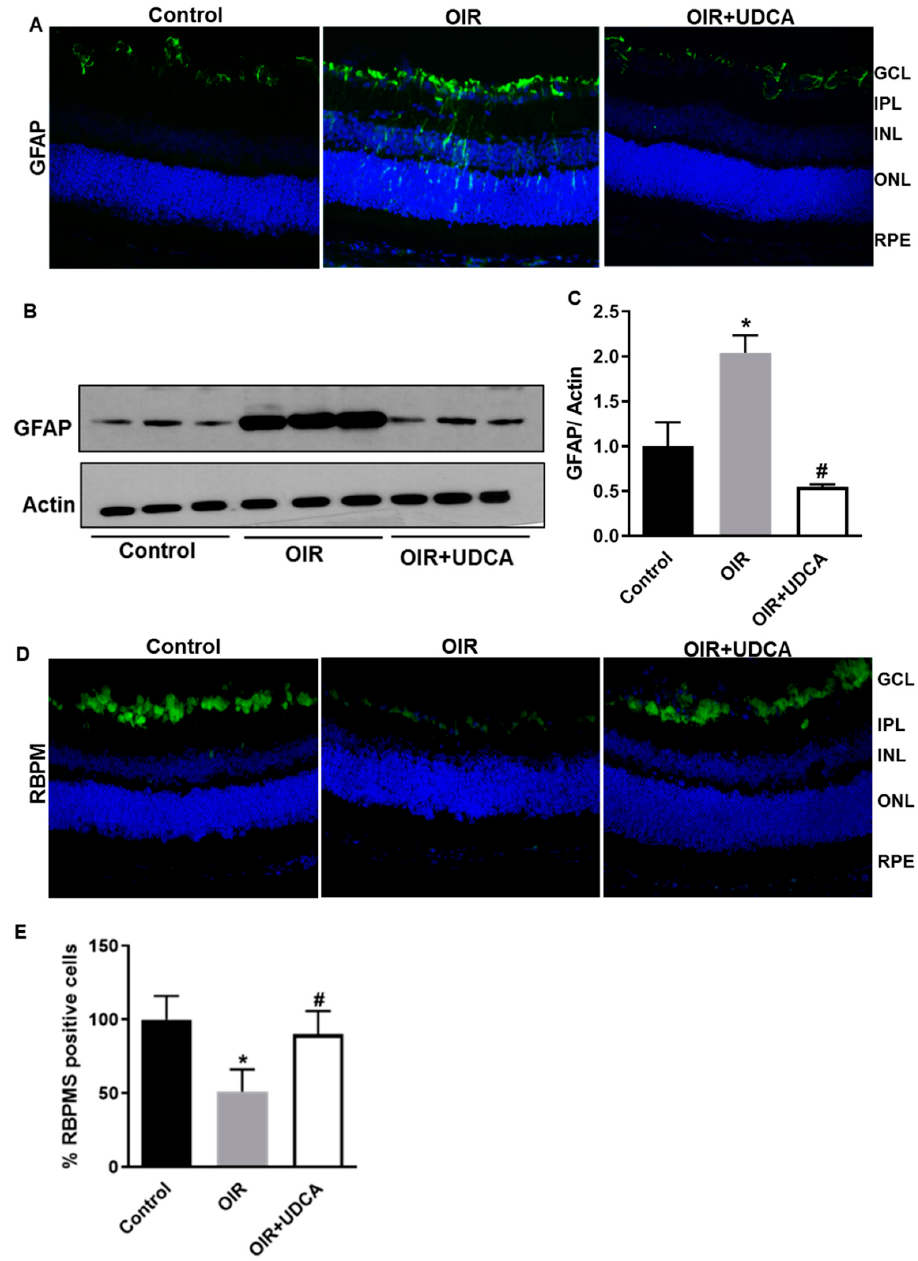
Figure 5. UDCA treatment halts reactive gliosis and preserves neuronal cells in OIR mice. Frozen retinal sections from control mice at P17 (room air), OIR mice, and OIR mice treated with 50 mg / kg UDCA (P7–P17) were stained with ( A ) GFAP antibody. Total protein fractions from control mice (room air), OIR mice at P17, and OIR mice treated with 50 mg / kg UDCA (P7–P17) were used to analyze ( B ) protein levels of GFAP by Western blotting. ( C ) Densitometry graphs showing changes in glial fibrillary acidic protein (GFAP) protein expressions. Values are mean ± S.D. ( n = 6 retinas per group). ( D – E ) Frozen retinal sections from control mice at P17 (room air), OIR mice, and OIR mice treated with 50 mg/kg UDCA (P7–P17) were stained with RNA binding protein with multiple splicing (RBPMS) antibody and positive cells were counted. RBPMS data are expressed as cell number/100 μ m retinal length and presented as a percent change from control. * p < 0.05 vs. control and # p < 0.05 vs. OIR. GLC: ganglion cell layer; IPL: inner plexiform layer; INL: inner nuclear layer; ONL: outer nuclear layer; RPE: retinal pigmented epithelium; RBPMS: RNA Binding Protein with Multiple Splicing; GFAP: Glial fibrillary acidic protein.